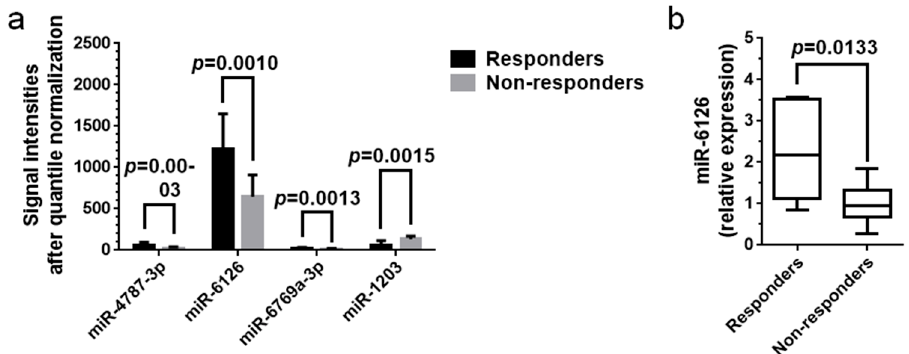
Figure 4. Validation of serum miRNA levels via real-time qPCR. ( a ) Average signal intensities of miRNAs in week-24 sera after quantile normalization of raw data. Although each miRNA was significantly differentially expressed between responders and non-responders ( p < 0.05), the signal intensities for miR-6126 were the strongest, and those for the other miRNAs were much weaker. The data suggested that miR-6126 was the most abundant miRNA in patient sera among the four miRNAs. The data were analyzed with Student’s t -tests and plotted with the mean and SD; ( b ) Real-time qPCR analysis validated the significantly higher expression of serum miR-6126 in the six responders compared with that in the sixteen non-responders ( p < 0.05). The other three miRNAs were not detected via real-time qPCR. Levels of serum miRNAs were normalized to the levels of cel-miR-39, an external control. Data were analyzed with Mann–Whitney U test and are presented as the median and range.